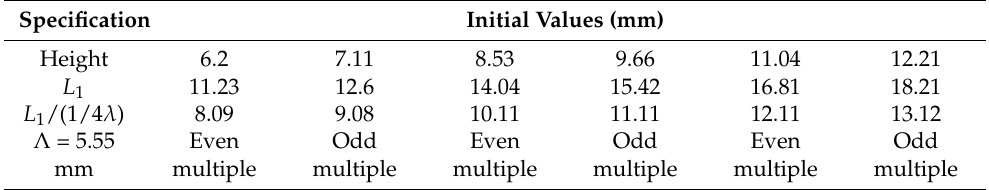
Table 4. The relationship between wedge block parameters and